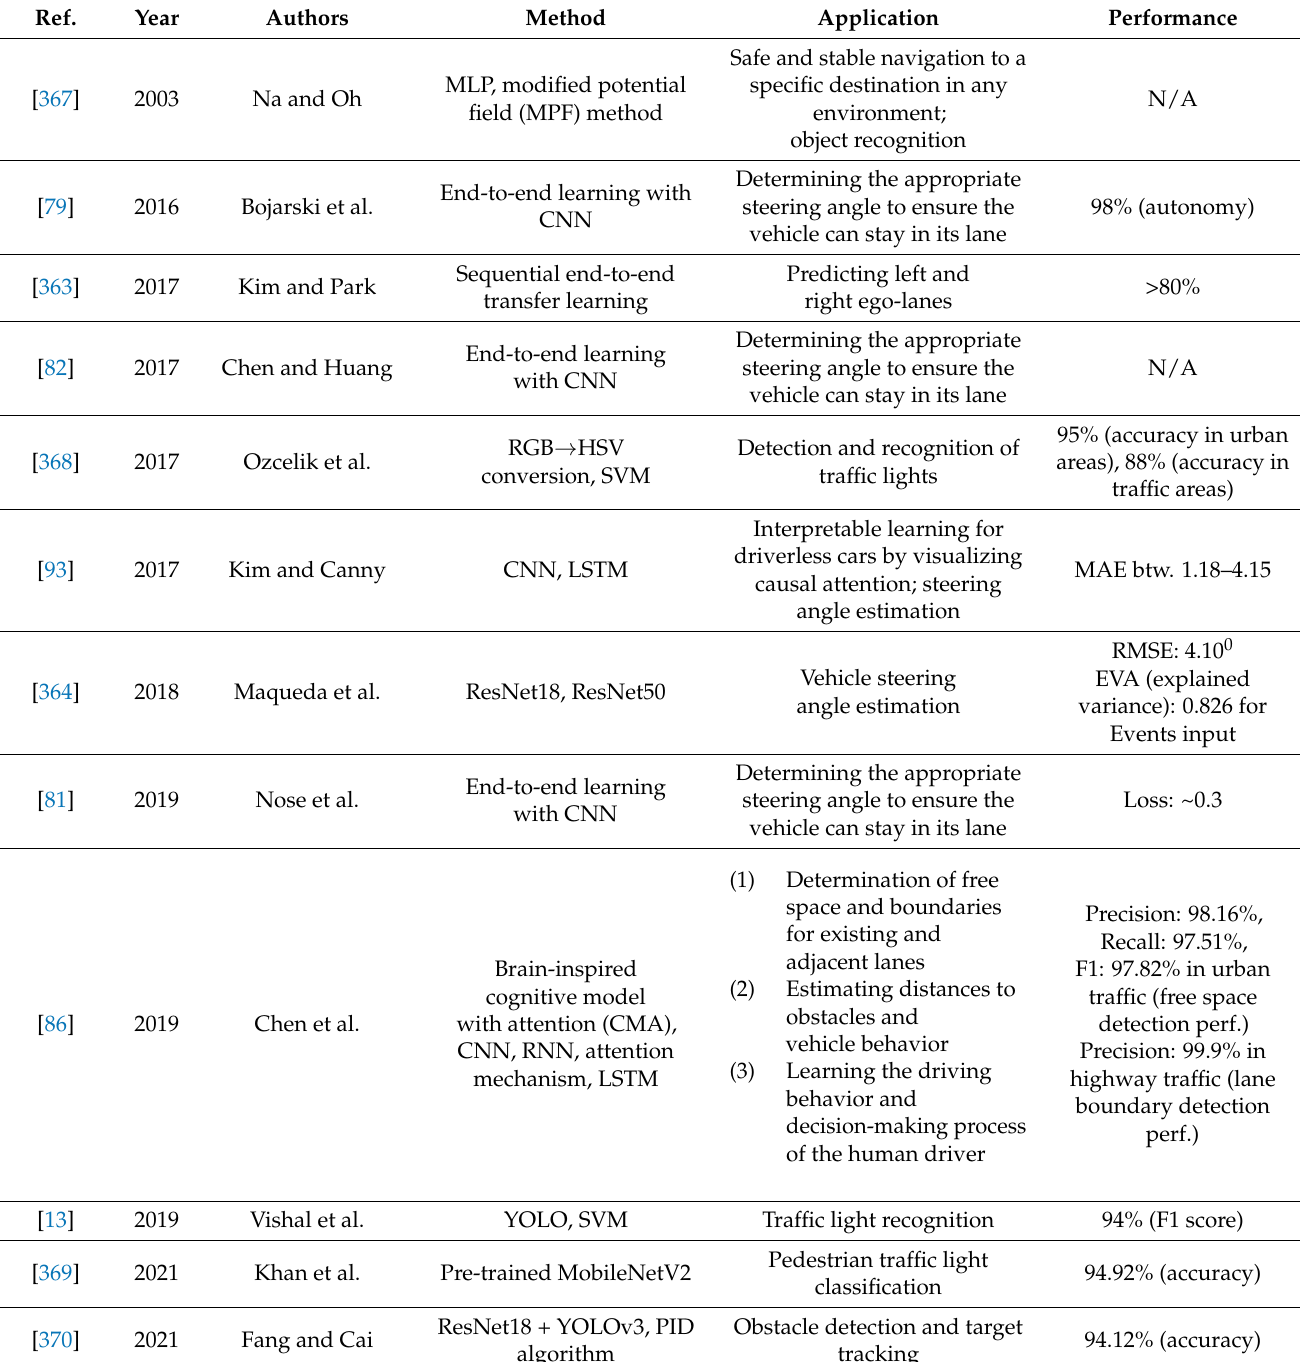
Table 11. Autonomous Vehicle/Robot Applications Using CV